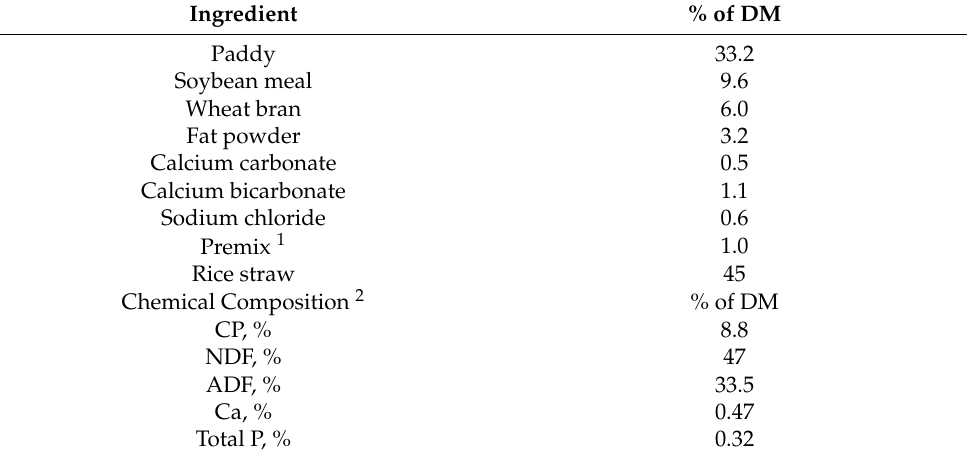
Table 1. Ingredients and nutrient compositions of experimental diets. Ingredient % of DM